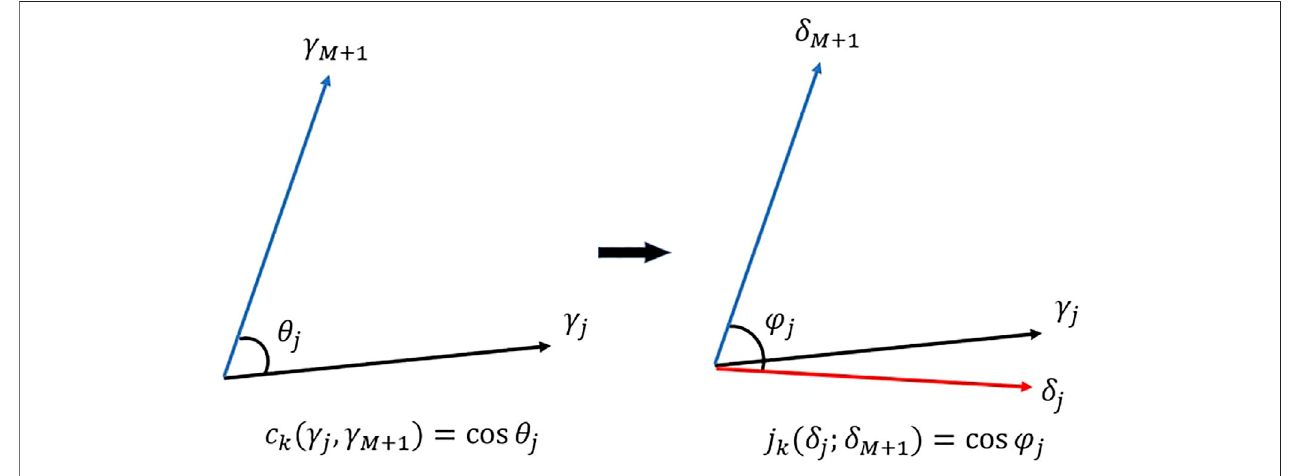
FIGURE 4 | Impact of measurement uncertainty